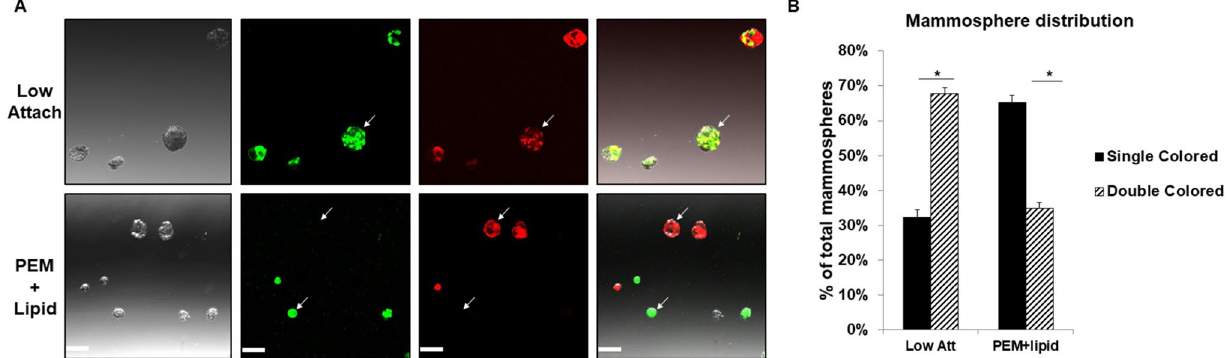
Figure 4. Lipid-coated wells have a higher proportion of clonal mammospheres compared to low attachment wells: ( A ) FACS was used to seed single cell suspensions of MCF7-GFP and MCF7-mCherry cells into 96 well plates. 500 cells of each cell type were sorted together into each well of low attachment and lipid-coated plates. Confocal imaging of mammospheres on Day 7 post-seeding shows that mammospheres in the low attachment plates are positive for both GFP and mCherry expression (top panels, white arrows), whereas the majority of the mammospheres observed in the lipid-coated plates are positive for either GFP expression or mCherry expression (lower panels, white arrows)—×10 magnification, scale bar 200 μm. ( B ) Quantification of mammospheres greater than 60 μm indicates that low attachment wells have significantly more